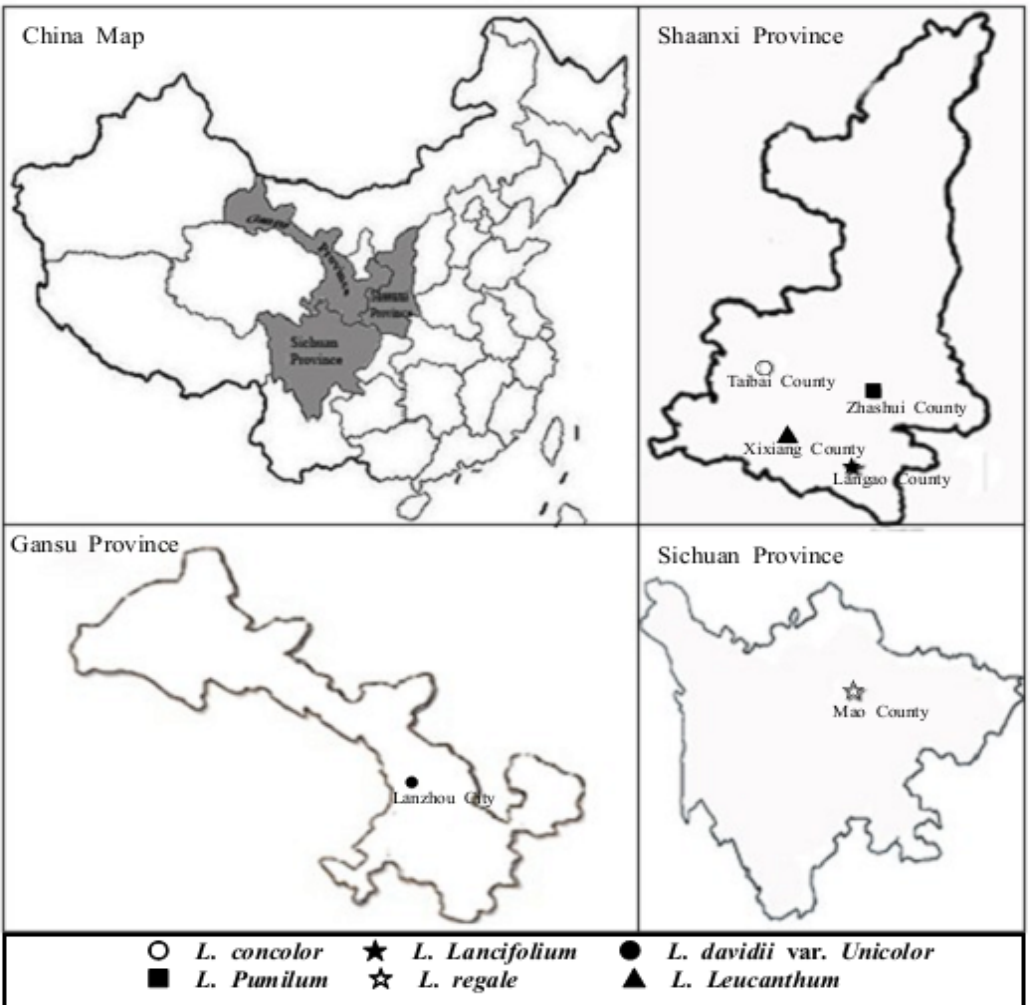
Figure 3. Collection sites of six Lilium species native to